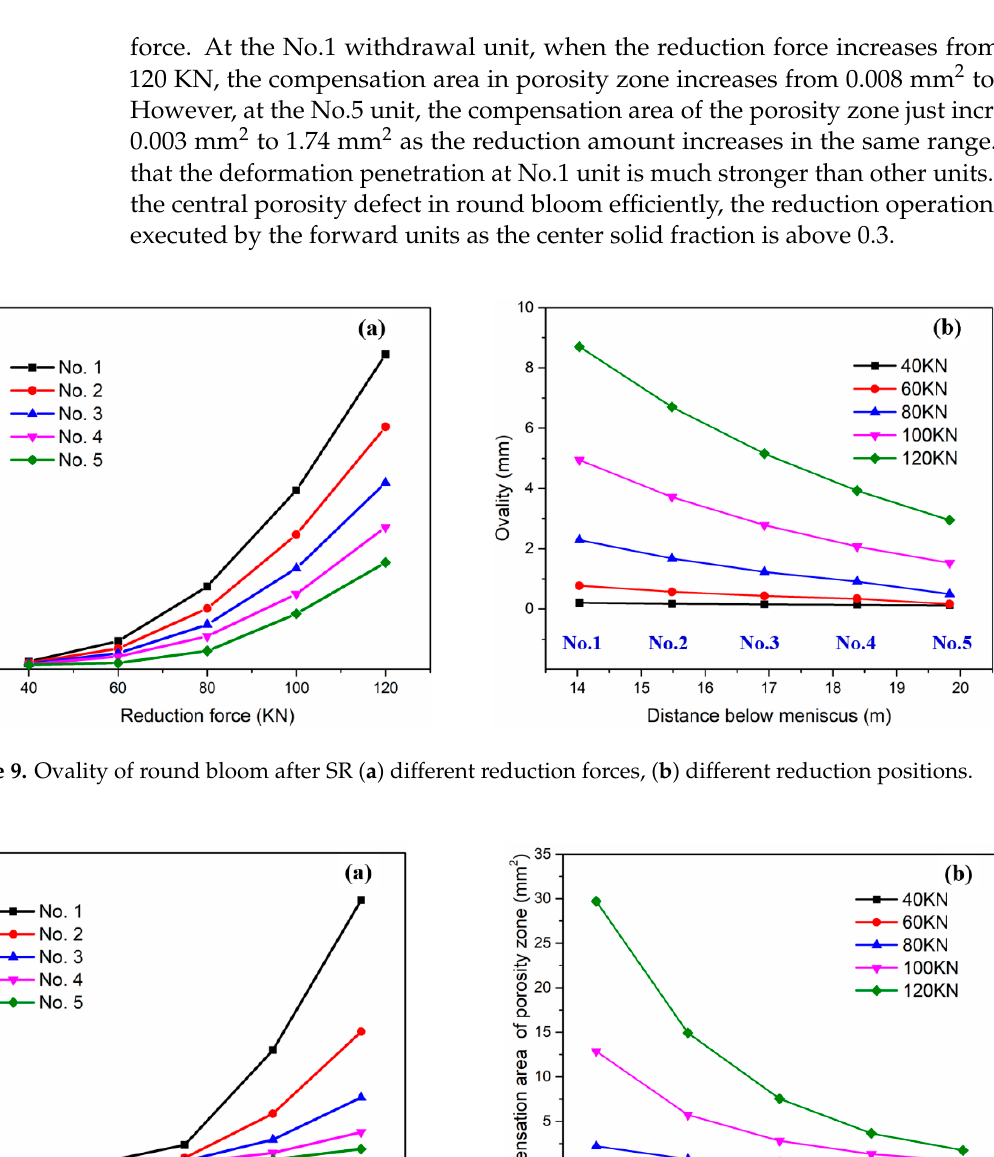
Figure 10. Compensation area of porosity zone ( a ) different reduction amounts, ( b ) different reduction positions.